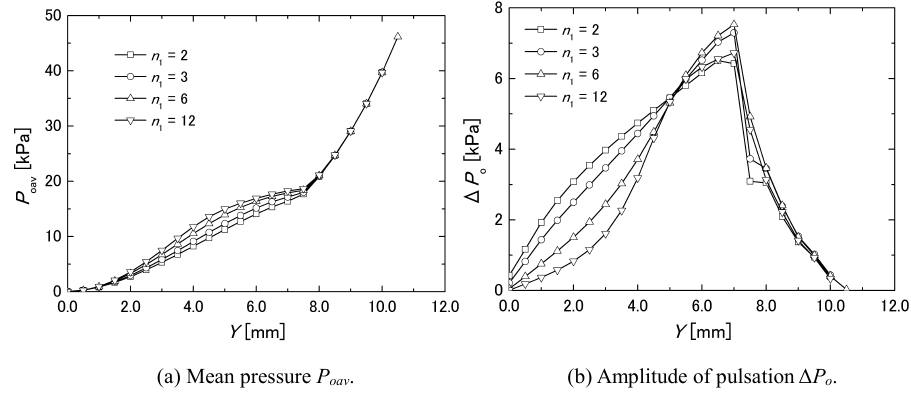
Fig. 10 Numerical reproduction of indentation experiment with four tube